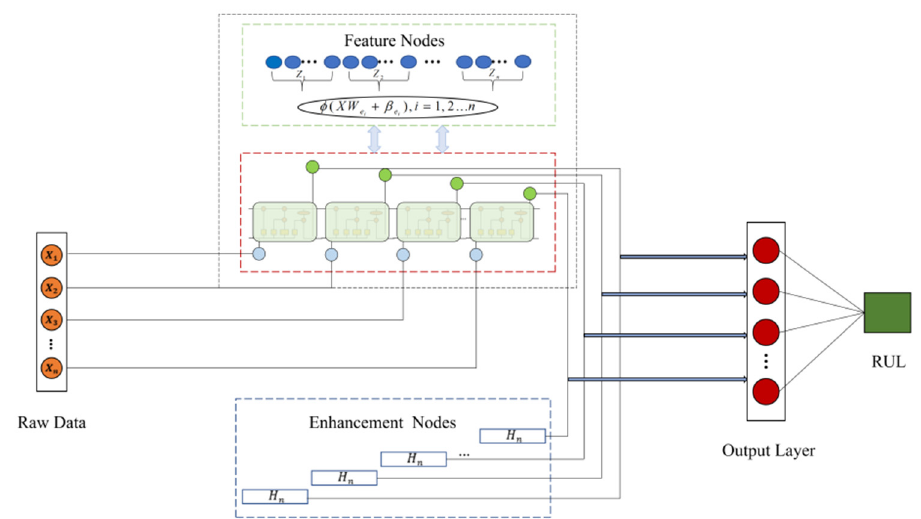
Figure 3. Structure of the B-LSTM network. Multiple orange circles in the left rectangle are the input data. The upper part in the middle indicates that the feature nodes of the new model are replaced by LSTM, the yellow circle in the LSTM part is the input data, the green circle is the feature nodes output by the new model, the lower part in the middle is the enhancement nodes generated by the feature nodes generated by LSTM, the feature nodes and enhancement nodes are connected to the output together, and the red circle on the right is the output of the